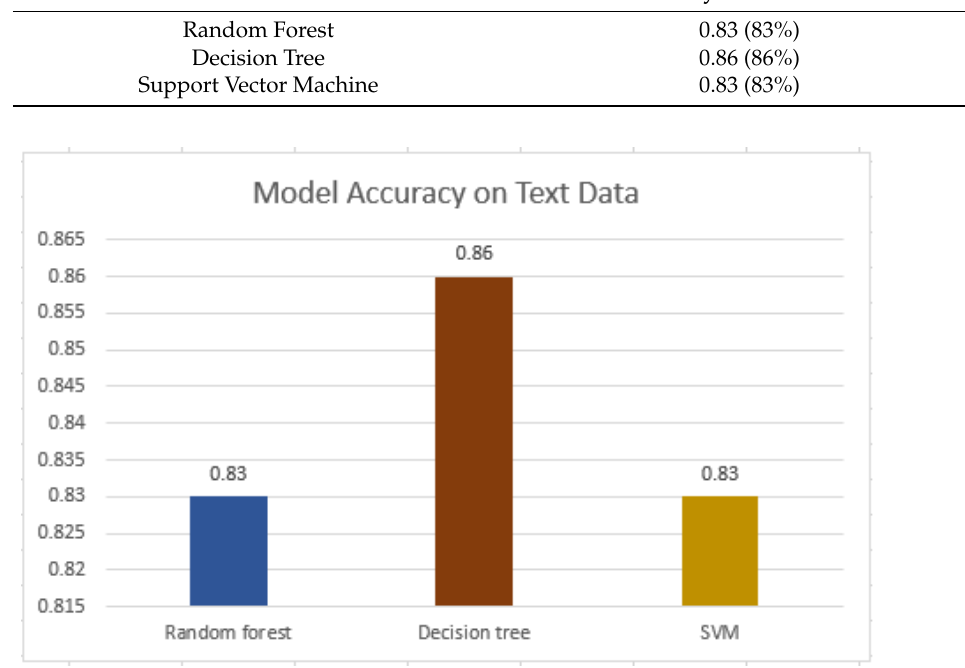
Figure 7. Accuracy of all three classifiers on text data only.